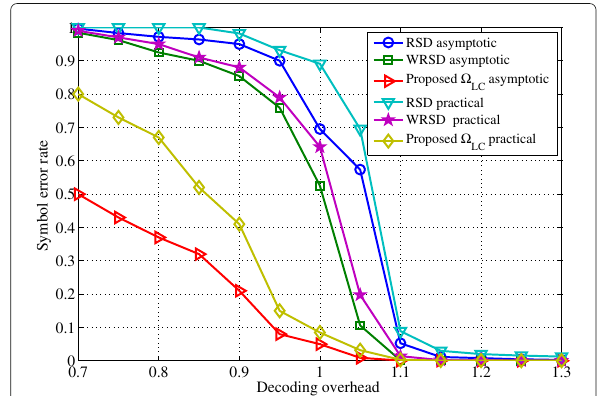
Fig. 4 Symbol error rate of the proposed degree distribution (cid:5) LC ( x ) . Symbol error rate SER of our proposed rateless codes with the linear mixed degree distribution (cid:5) LC ( x ) , compared to other conventional degree distributions. Code length k